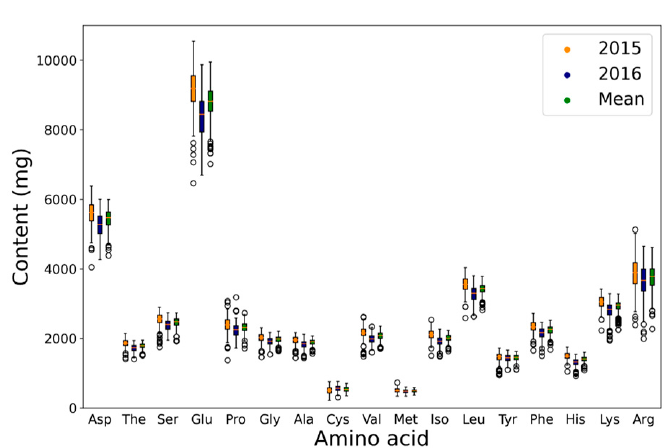
Figure 2. Distribution of protein and oil content in 203 wild soybean accessions. Asp, aspartic acid; Thr, threonine; Ser, serine; Glu, glutamic acid; Pro, proline; Gly, glycine; Ala, alanine; Cys, cysteine; Val, valine; Met, methionine; Iso, isoleucine; Leu, leucine; Tyr, tyrosine; Phe, phenylalanine; His,